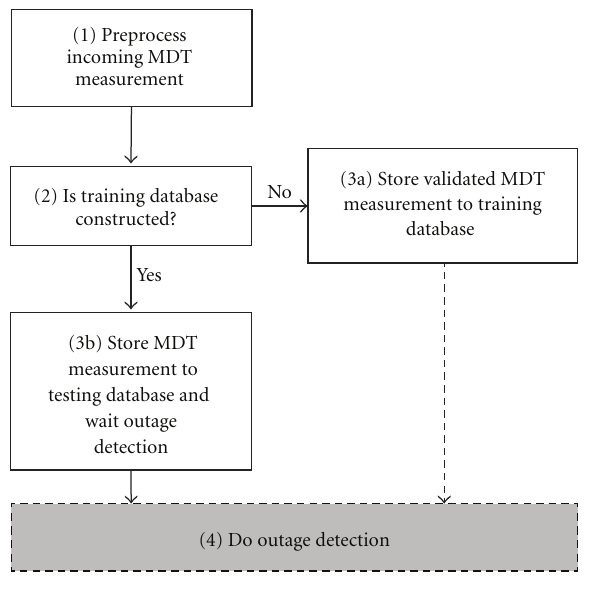
Figure 2: Data-mining learning phase description.